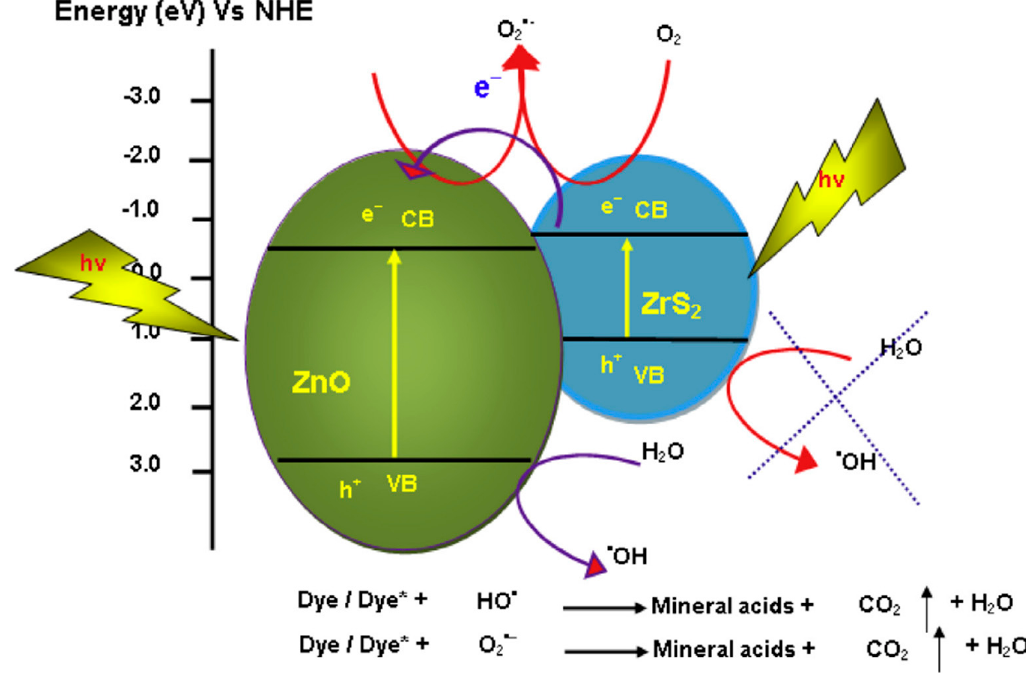
Figure 4. Photocatalytic mechanism for ZnO/ZrS 2 nanocomposite [58]. Reproduced with the permission of Separat. Purif. Tech. Table 3. Other nanocomposites for photo-degradation of azo dyes.